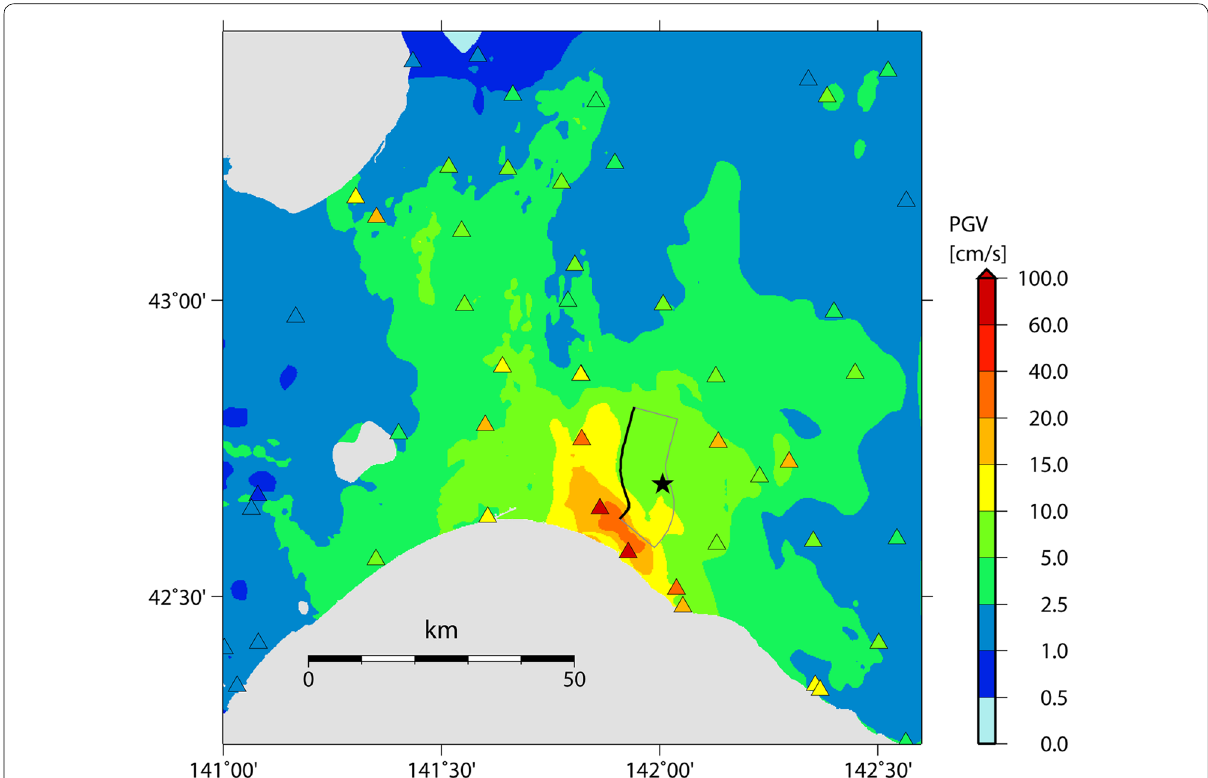
Fig. 5 Simulated PGV distribution. The PGV is the maximum absolute amplitude of the vector sum of the three-component velocity waveforms low-pass filtered at 0.5 Hz. The triangles denote the observed PGV at K-NET and KiK-net stations for